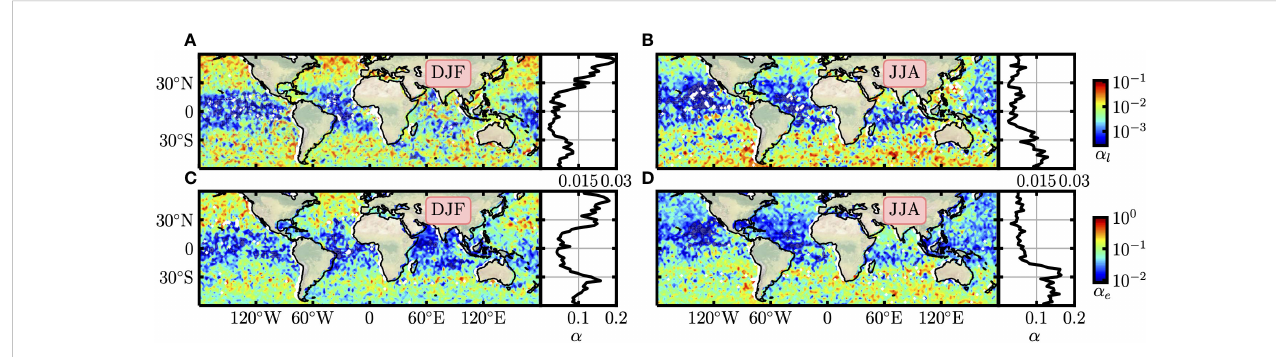
FIGURE 9 The global distributions of a l measured with linearly decomposed (cid:1) Hs Ll in (A) DJF and (B) JJA. (C, D) are the a e derived from the (cid:1) Hs Le decomposed by energy conservation theory. The meridional variations are shown in the right